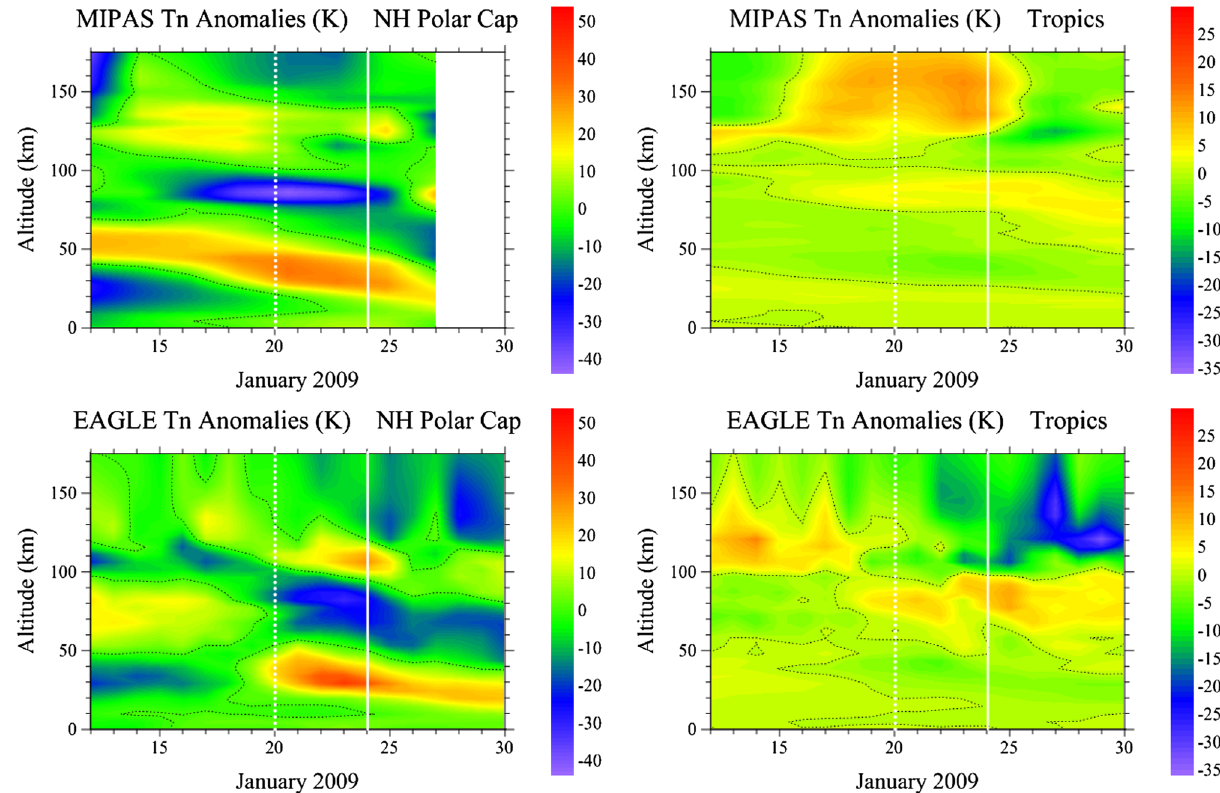
Fig. 1. Day-to-day variability of zonal mean neutral temperature anomalies during January 2009 above the northern polar cap (70 (cid:3) – 90 (cid:3) N, left panels) and above the tropics (20 (cid:3) S – 20 (cid:3) N, right panels) obtained using MIPAS observational data (top) and EAGLE model results (bottom). Vertical lines indicate the onset (dotted) and peak (solid) of the 2009